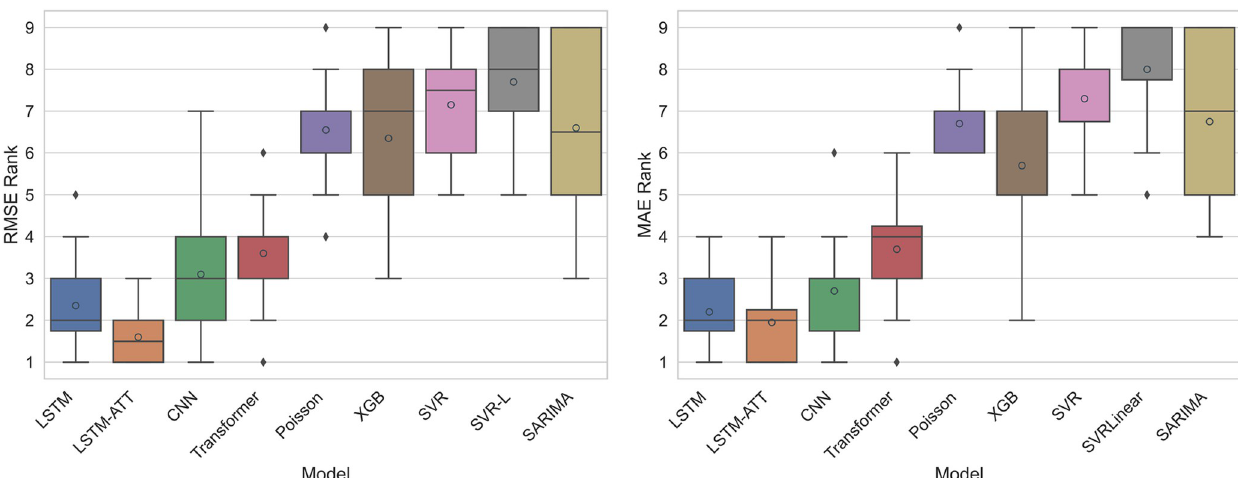
Fig 5. DF forecasting models with RMSE- and MAE-based rankings. Rankings are based on the relative scores for lowest RMSE or MAE in the prediction of dengue fever one month ahead. Grey-outlined circles indicate mean values. RMSE = root mean square error. MAE = mean absolute error. LSTM = long short-term memory. LSTM-ATT = attention mechanism-enhanced LSTM. CNN = convolutional neural network. Poisson = Poisson regression. XGB = XGBoost Extreme Gradient Boosting. SVR = Support Vector Regressor with Radial Basis Kernel. SVR-L = Support Vector Regressor with Linear Kernel. SARIMA = Seasonal Autoregressive Integrated Moving Average.